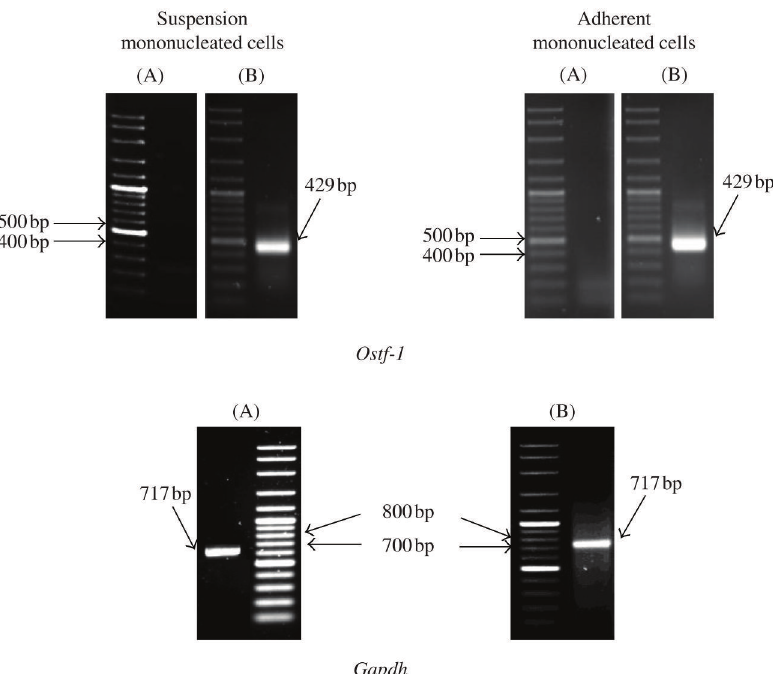
FIGURE 4: Active and inactive osteoclast progenitor markers and housekeeping gene in suspension and adherent mononucleated cells. (A) Ostf-1 in undifferentiated mononucleated cells. (B) Ostf-1 in mononu- cleated cells after 3 days in osteoclast differentiation medium. Gapdh is represented in suspension and ad- herent undifferentiated mononucleated cells (Left) and mononucleated cells after 3 days in osteoclast dif- ferentiation medium (Right). Ostf-1 was not active in mononucleated cells but was active after 3 days in os- teoclast differentiation medium. The positive control, Gapdh , was active before and after differentiation of mononucleated cells into